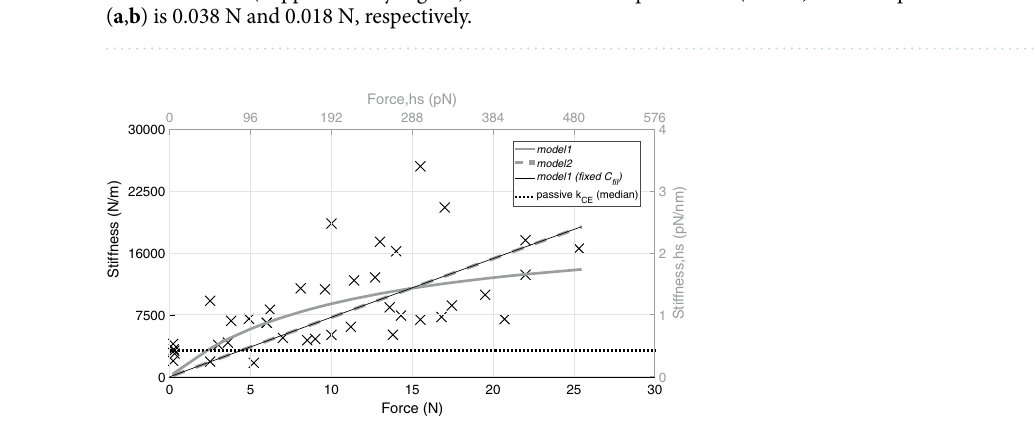
Figure 4. Contractile element stiffness ( k CE ). Trial specific k CE values were inferred from a 3-parameter fit (Eq. 1), with information from one oscillation period after TD (Supplementary Fig. S1). k CE is also given as scaled to the dimension of one representative half-sarcomere ( k hs , right axis, see Eq. 2). The correspondingly scaled isometric force per half-sarcomere (Eq. 3) is given on the upper axis. The solid and dashed grey lines represent the model1 and model2 fits (see Table 2), respectively. The dotted, horizontal, black line indicates the median of passive k CE values. The thin, black line underlying the model2 fit, is the model1 fit with only the 0.0067 nm pN − 1 parameter (cid:31) L CE open (fixed C fil = 5N , as well as ζ 1 for the MTC at F 0.8 and ζ 1.1 (Table 1). From this, we find the damping ratio ζ = = = = for 2.5N and 7.5N , respectively. Thus, the MTC is critically damped at 20% of F max (Fig. 1), under-damped for activity lower 20%, and slightly over-damped for higher activity levels. If the muscle force directly relates to muscle activity 19,20 (see also stiffness fits in Supplementary Fig. S4), then the 20% of F max in Fig. 1 is the same as the pre-activation in human GAS before TD (20%) 21 . Accordingly, the number of cross-bridges before an impact relates to soft tissue vibration control in the first few milliseconds after TD. Several studies have experimentally investigated the association between muscle activation and almost critical damping of muscle vibration in response to an impact 1,5,6 , which lead to the muscle-tuning paradigm 5 . However, a limitation of conducting impact experiments with human subjects is the inability to decouple any effect of leg geometry, joint compliance and muscle activity. Conversely, a benefit of our ex-vivo setup is the direct control over GAS isometric force generation and the impact situation: soft tissue MTC properties and condi- tions affecting its vibration responses can be manipulated independently of the impact strength (falling height).